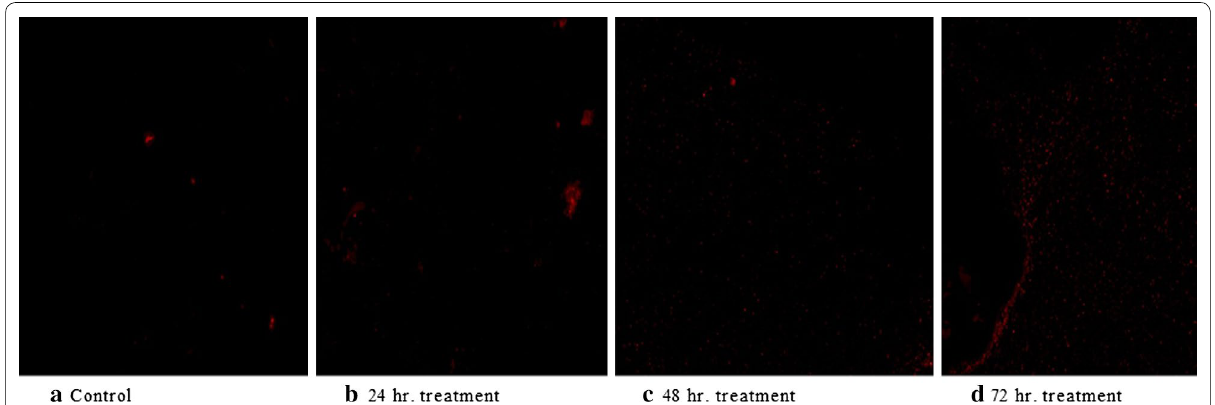
Fig. 2 Fluorescence microscopy image of Bacillus subtilis stained with propidium iodide at varying period of time. a Control, b 24 h treatment, c 48 h treatment, d 72 h